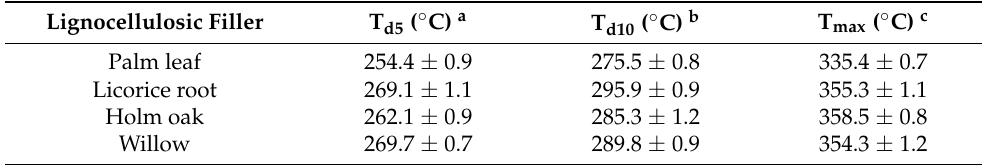
Table 3. Thermal degradation parameters for the different natural fillers.